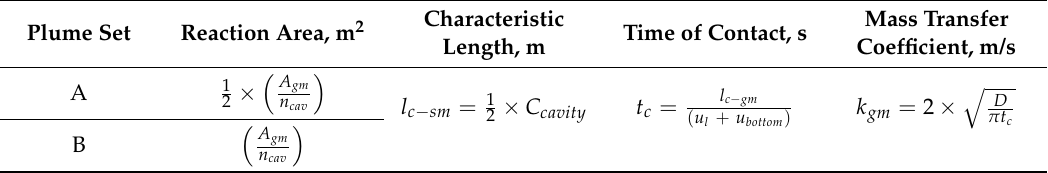
Table 1. Evaluation of mass transfer parameters at impact zone (gas-metal interface). Plume Set Reaction Area, m 2